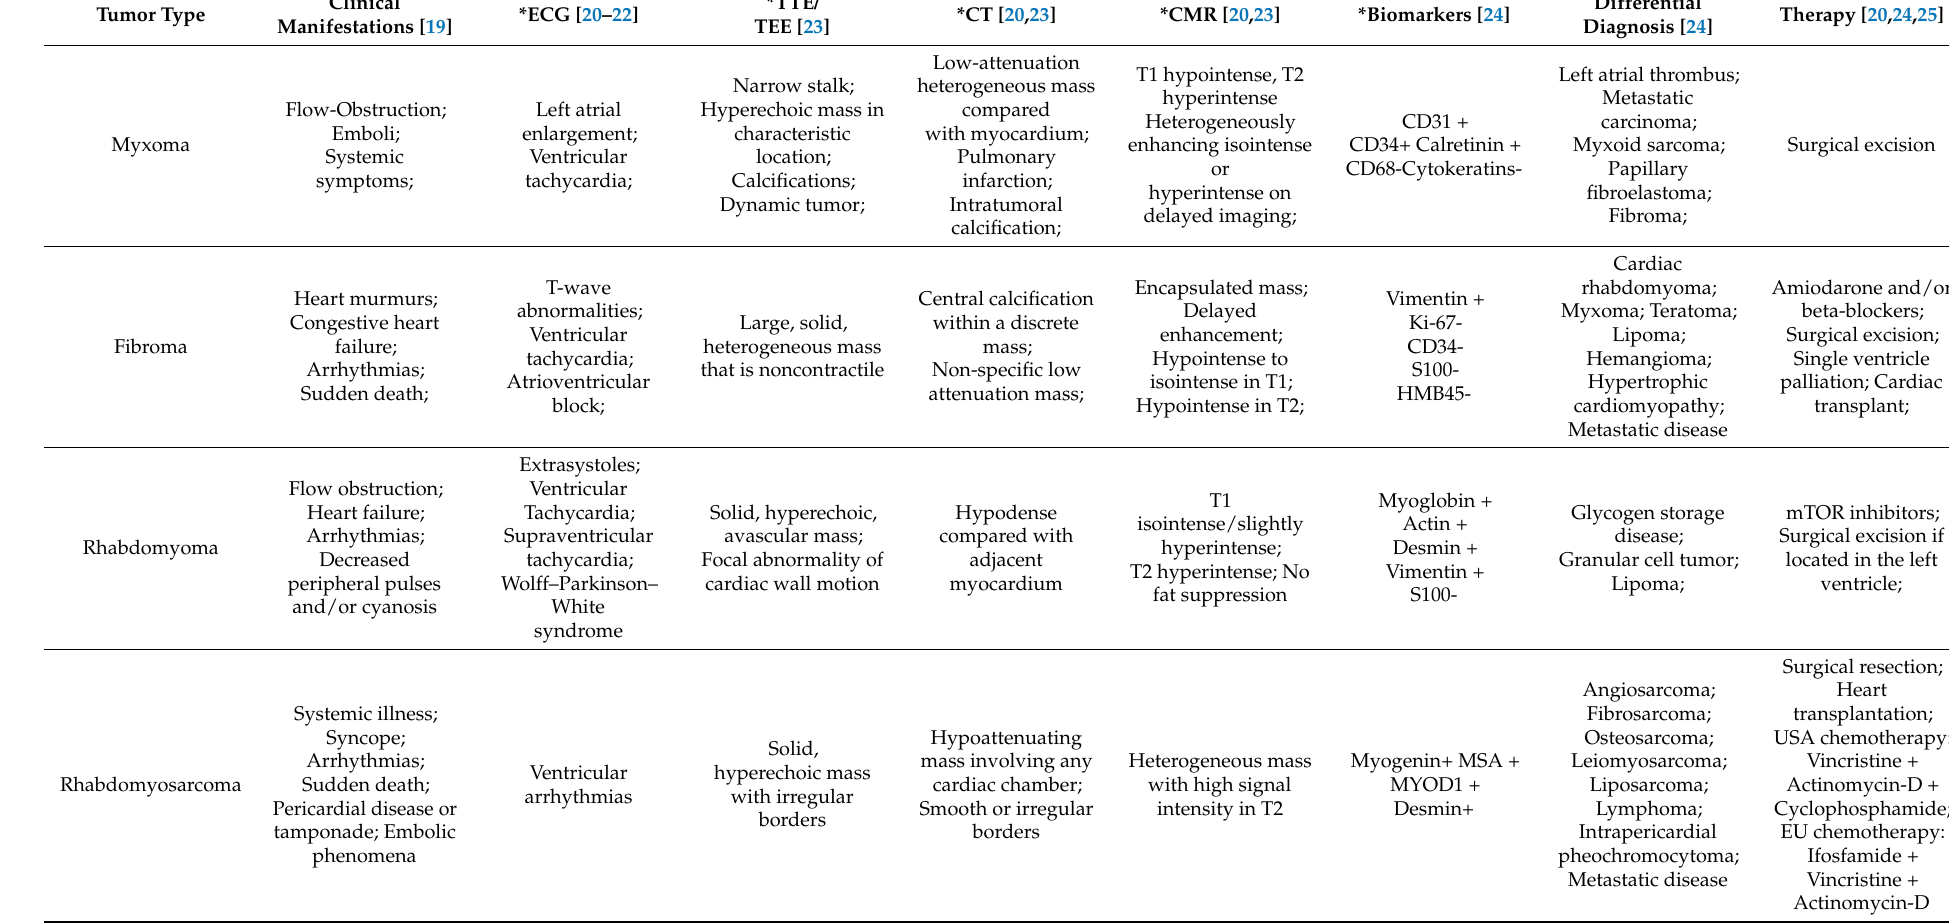
Table 2. Differential diagnosis for myxoma, fibroma, rhabdomyoma, and rhabdomyosarcoma with their clinical manifestations and imagistic criteria based on *ECG-electrocardiogram, *TTE/TEE-Transthoracic echocardiography, *CT-Cardiac computed-tomography, *CMR-cardiac magnetic resonance, biomarkers as well as therapeutic